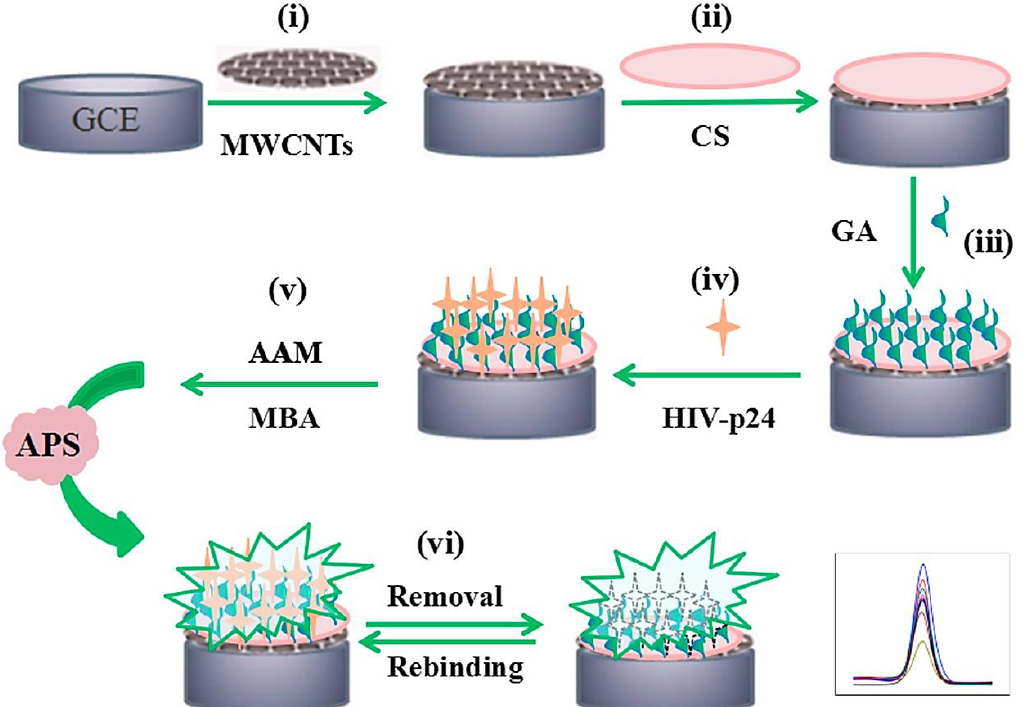
Figure 6. Detailed procedure diagram for fabrication of the HIV-p24/CTS/MWCNT/GCE sensor (adapted by permission from Reference [42]).